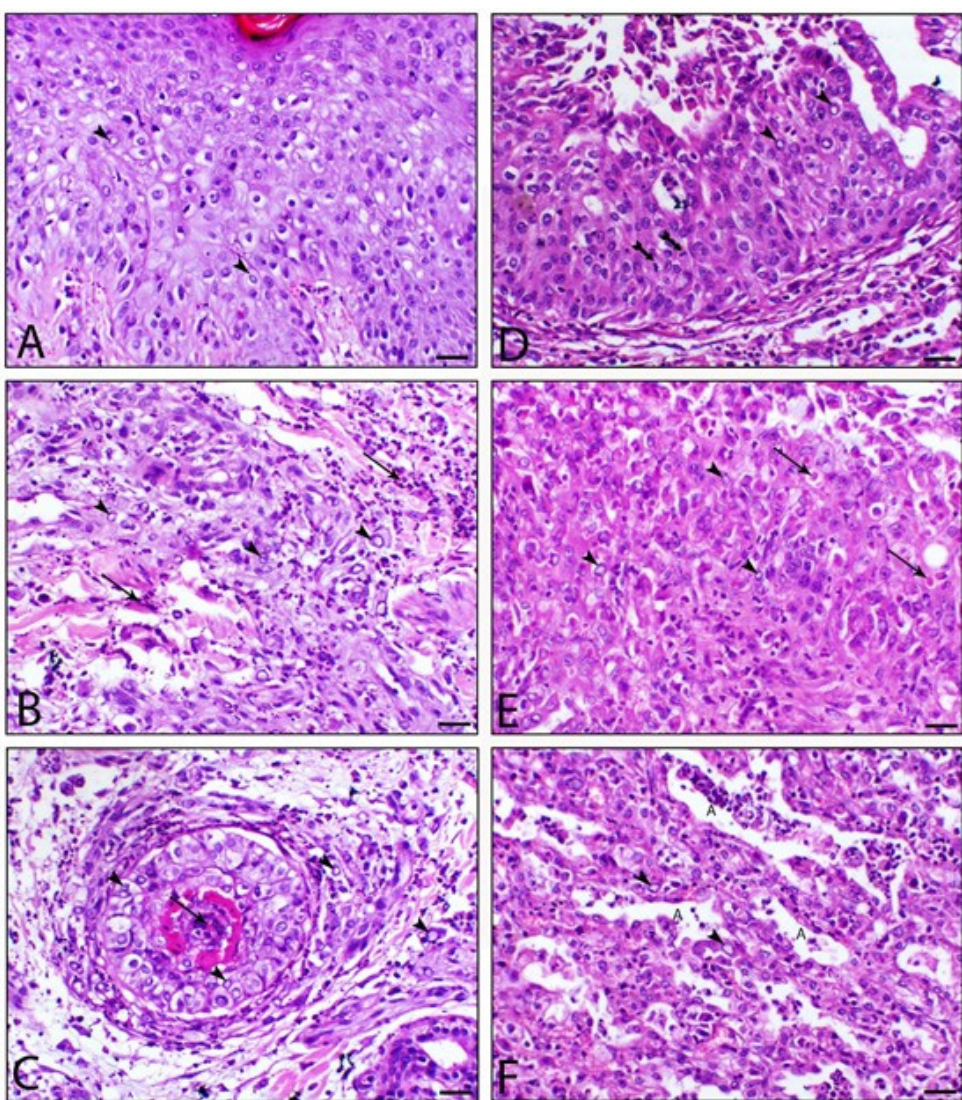
Figure 2. Cutaneous and pulmonary sections of infected sheep with SPV. Figures ( A – C ) represent the skin, and Figures ( D – F ) represent the lung. Epidermal layer showing ballooning degeneration with macrovesicles formation associated with the presence of intra-epithelial sheeppox cells (arrowheads), ( B ) dermis showing dermatitis associated with the necrosis of the collagen with marked inflammatory cell infiltration of mostly macrophages and histocytes and sheeppox cells (arrowhead) and ( C ) showing the necrosis of hair complex with marked infiltration of sheeppox cells. ( D , E ) Bronchial section showing the stratification of the lining epithelium associated with the degeneration of epithelial cells, the hyperplasia of the basal epithelial cells (tailed-arrow), and intracytoplasmic inclusion bodies (arrows). ( F ) Feature of interstitial pneumonia associated with marked thickening of the interalveolar septa and the marked infiltration of macrophages, histocytes, and sheeppox cells (arrowhead), A letter indicates atelectatic alveolar spaces, H&E, bar = 50 µm.